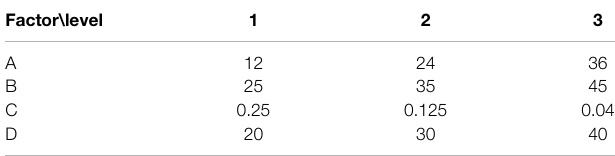
TABLE 2B | Orthogonal experimental data of 2-FSMN branched molecule